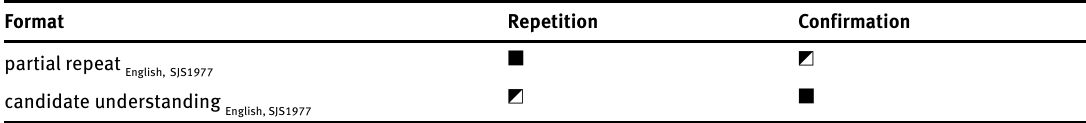
Table 3: Two properties of restricted repair initiators and their relations to two formats identified in English conversations, showing potential ambiguity or overlap in